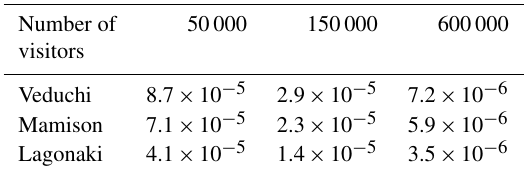
Table 4. Individual risk values in Veduchi, Mamison and Lagonaki ski